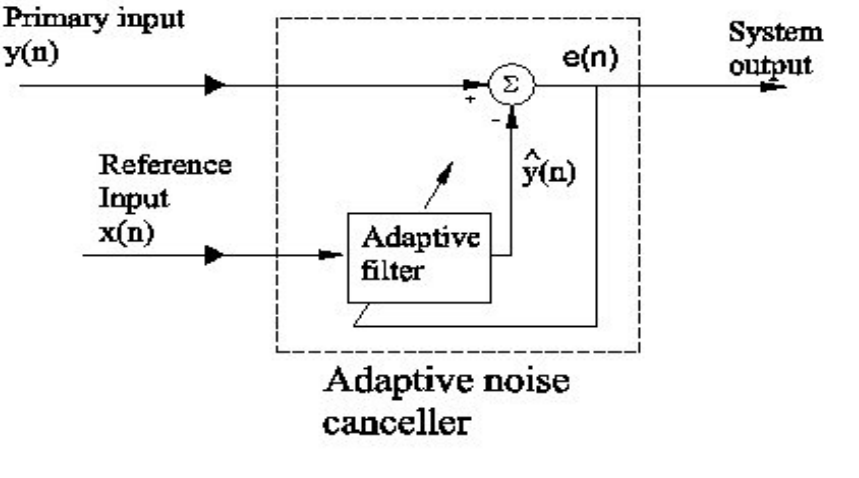
Figure 3. Block diagram representation of the adaptive